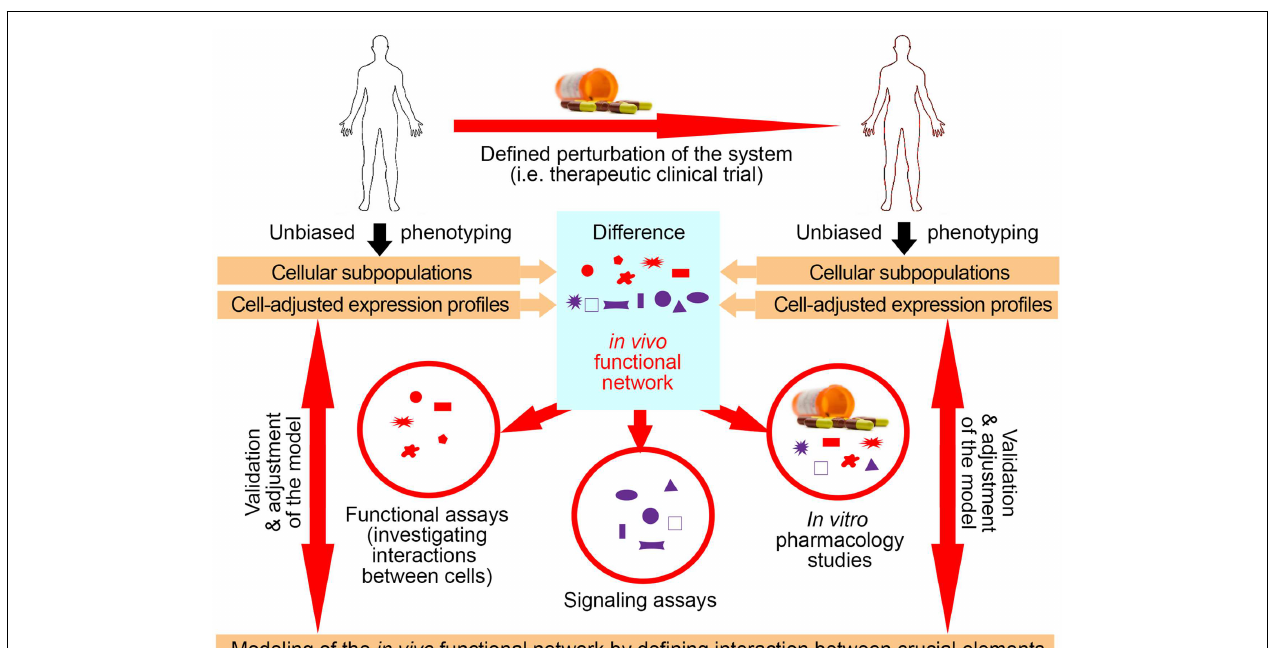
lack of B cells has to directly or indirectly explain the observed functional deficit inT cells, asT cells do not express CD20, the target of rituximab. Of course, it was known before initiation of rituximab trials thatT and B cells interact together, but by analyzing samples from clinical trials of daclizumab we gained new insights into elements of the immune system that had previously been obscure such as innate lymphoid cells and their unexpected role in the MS disease process. Elements that are changing synchronously by applied therapeutic perturbation are part of the same “ in vivo functional network” that has been disturbed by treatment. Identification of gene transcripts, proteins, and cell types that interact with each other in vivo then greatly facilitates investigation of interactions between these elements in simplified models, such as in vitro functional assays, ex vivo signaling assays, or in vitro pharmacology studies. Mechanistic insight (i.e., identified protocols) gained from these simplified models has to be verified in vivo , either by studying a new set of patients or by applying new